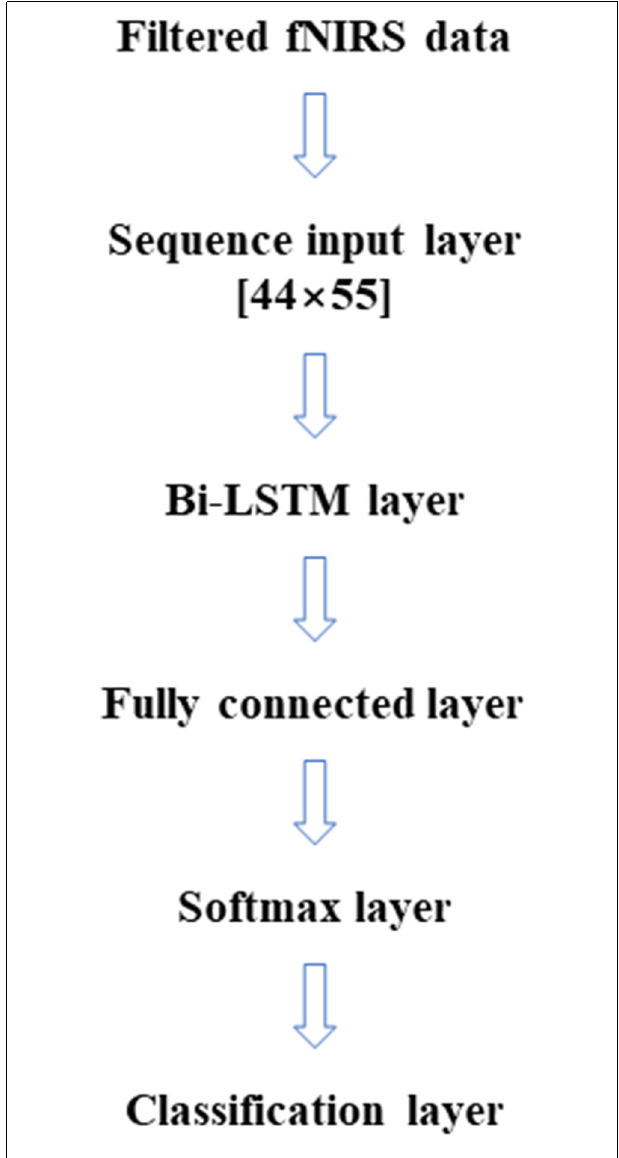
FIGURE 2 | Simple bi-LSTM model for classification.